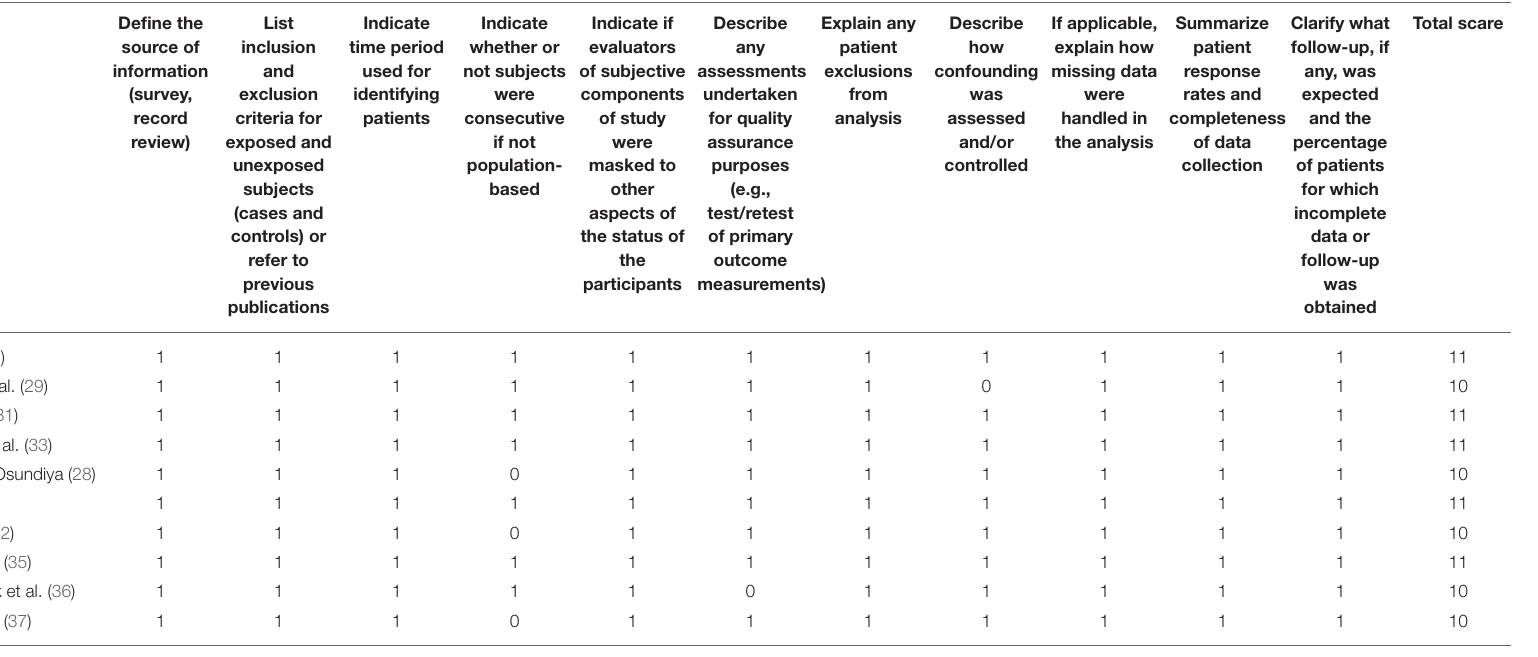
TABLE 2 | Bias of included cross-sectional